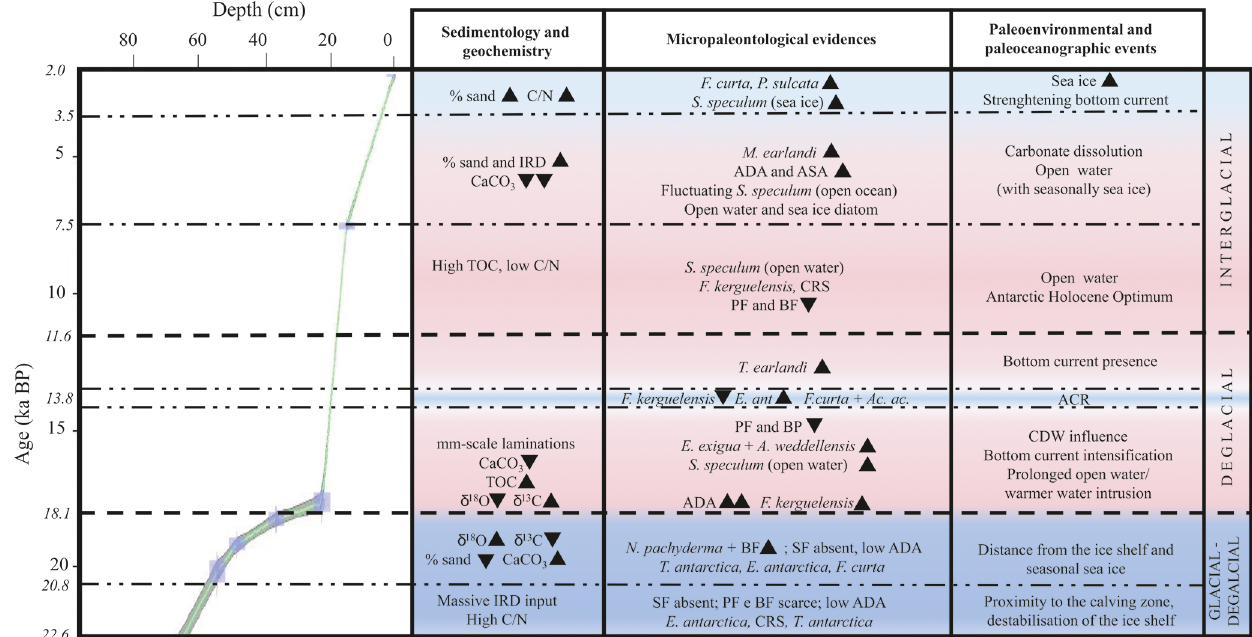
Figure 6. Age–depth plot for core KI13-C2 in the investigated interval. The main paleoenvironmental changes are illustrated, supported by geochemical, chemical, sedimentological, and micropaleontological data. The blue areas represent colder periods, and the pink areas represent warmer periods. Bold horizontal dashed lines are visual divisions between the three intervals discussed in the text; dotted lines highlight the main paleoenvironmental phases. Black triangles indicate increasing or decreasing relative occurrences of species. IRD: ice- rafted debris; TOC: total organic carbon; C / N: carbon / nitrogen ratio; ADA and ASA: diatom and silicoflagellate concentration, respectively; CRS: Chaetoceros resting spore; SF: silicoflagellates; PF: planktic foraminifera; BF: benthic foraminifera; ACR: Antarctic Cold Reversal; CDW: Circumpolar Deep